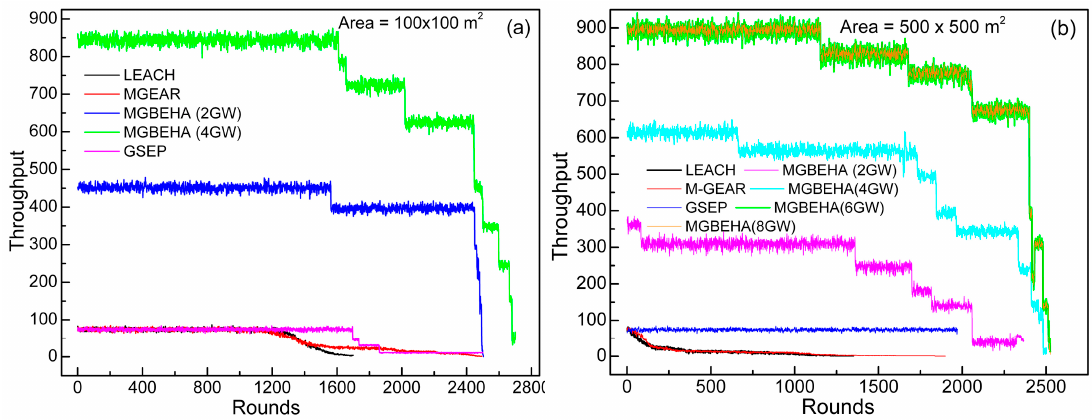
Figure 4. Variation of throughput for different protocols in ( a ) 100 m × 100 m, and ( b ) 500 m × 500 m area. CASE 1: Results analysis of 100 nodes in 100 × 100 m 2 area (Table 3)